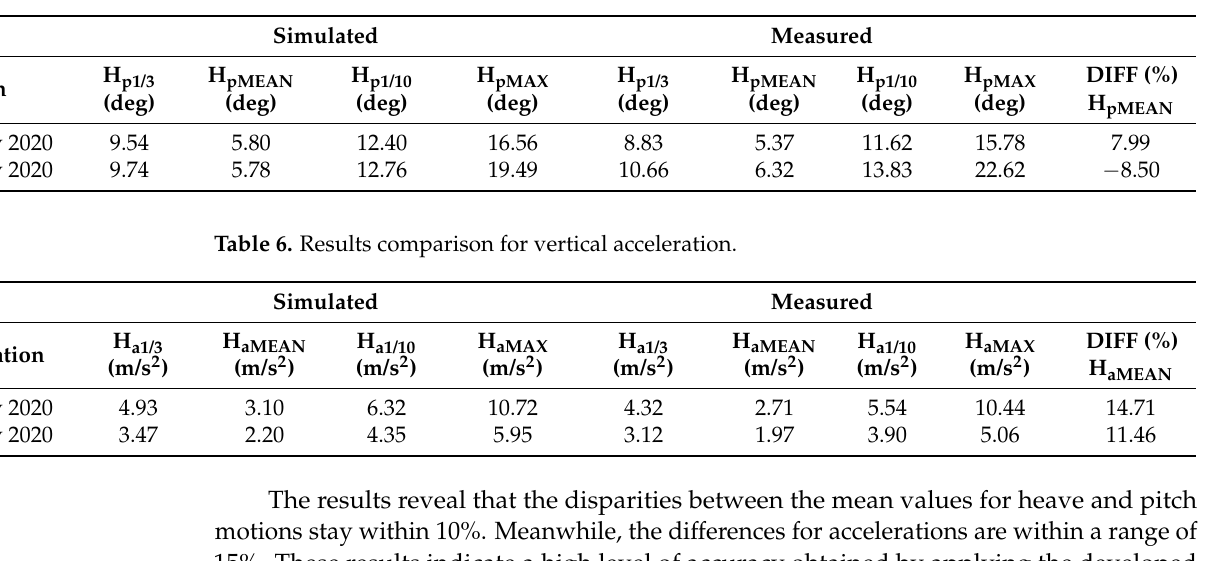
Table 5. Results comparison for pitch motion.